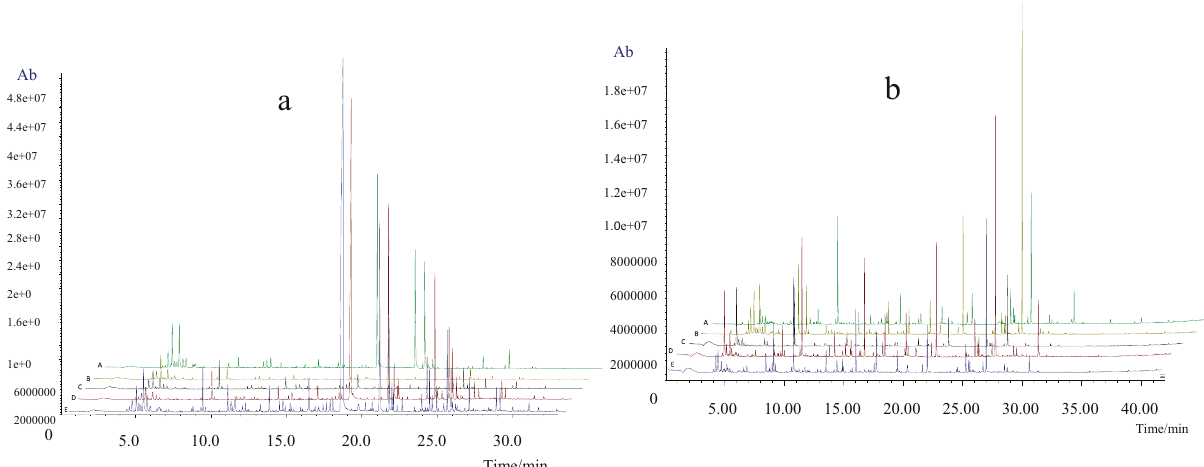
Figure 1: Total ion chromatography pro fi les of fl oral scent emitted from rose and tulip during the daytime (( a ) Rose, ( b ) Tulip, ( A ) 9:00, ( B